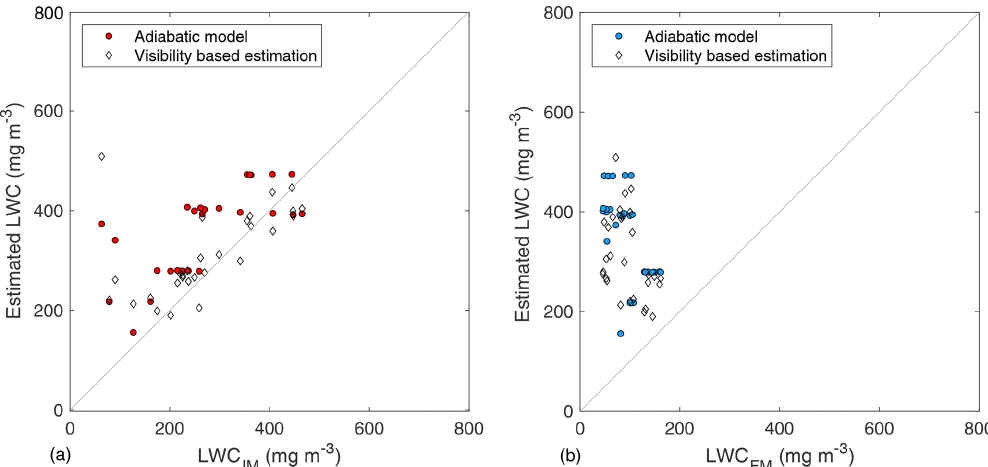
Figure 11. Amount of LWC using a simple adiabatic model and visibility-based estimation compared with observed LWC measured utilizing cloud spectrometers (a) ICEMET and (b)